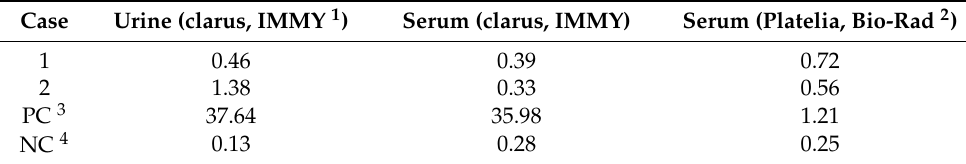
Table 1. Galactomannan results of the two patients with acute pulmonary histoplasmosis following